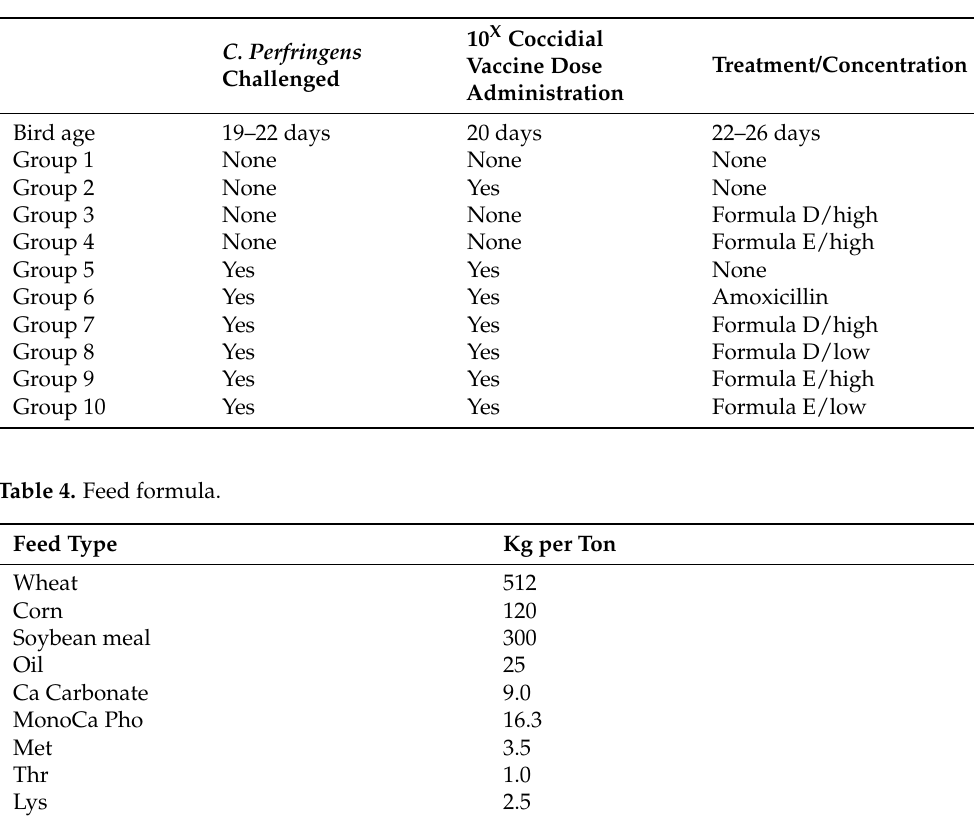
Table 3. Experimental groups.